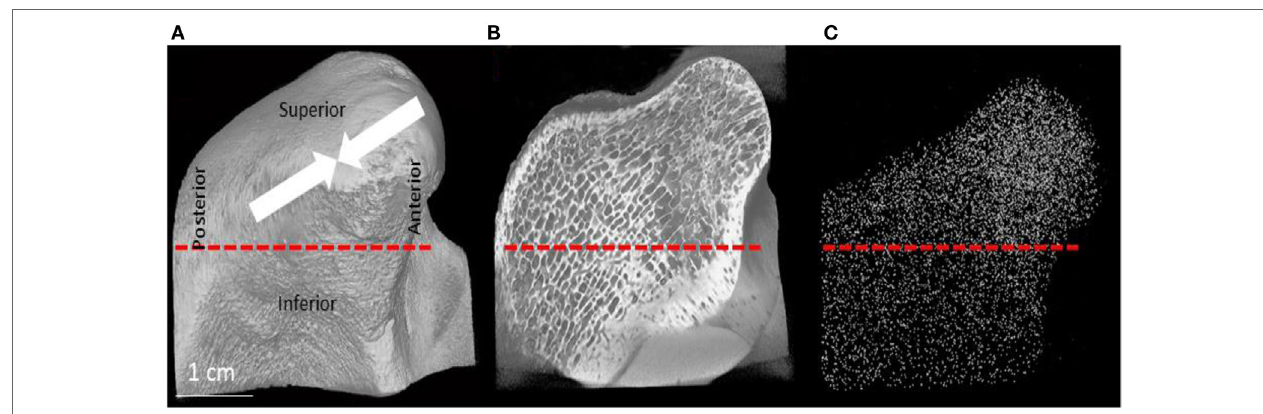
FigUre 8 | (a) μ CT image of the condylar head and neck of the pig. The arrows show the major compressive stress trajectories, as shown by Liu and Herring (2000a,b). (B) Section through the 3D μ CT image of the condylar head and neck and (c) is a plot of the locations of all the 3-N nodes in the whole volume of the scan projected onto this plane. (c) Visually demonstrates that there are more 3-N nodes in the condylar head as compared to the neck.